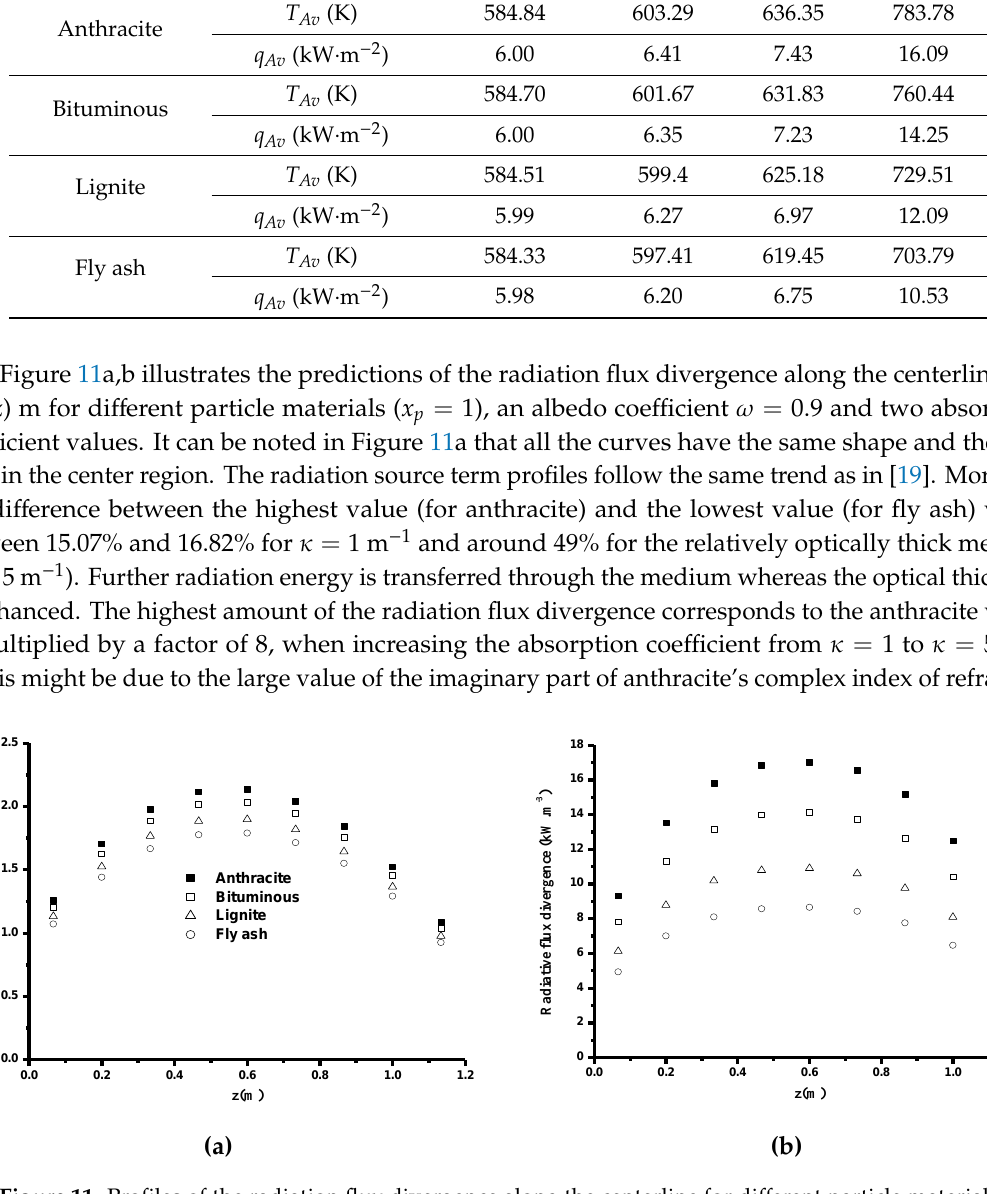
Figure 11. Profiles of the radiation flux divergence along the centerline for different particle materials ( x p = 1, ω = 0.9): ( a ) κ = 1 m − 1 , ( b ) κ = 5 m − 1 .